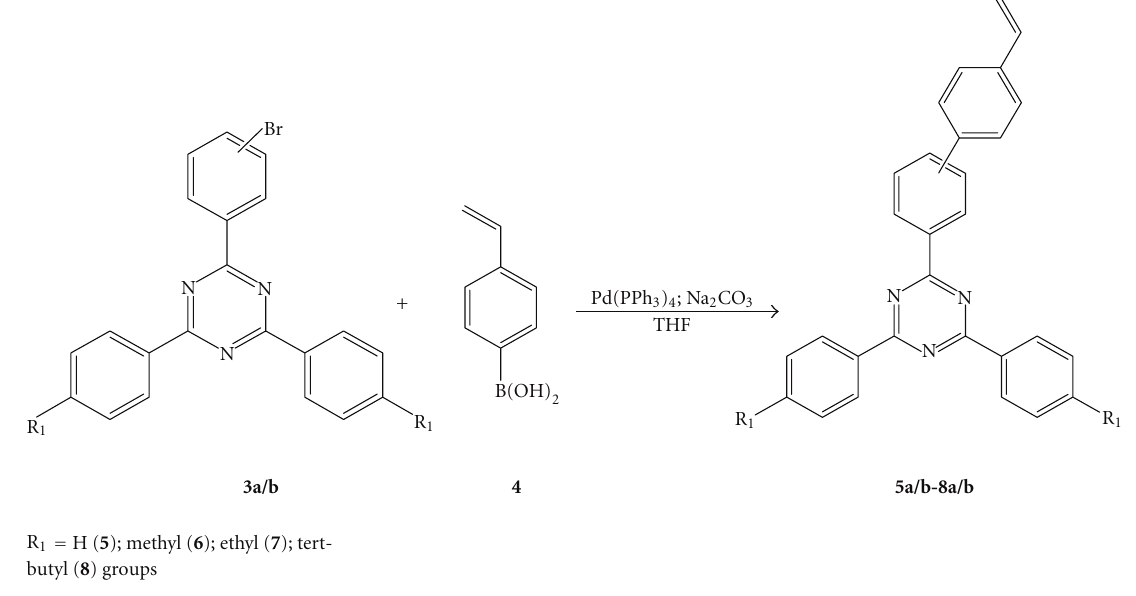
Figure 3: Introduction of styryl functionality by Suzuki coupling (a: meta; b: para). Table 1: Overview of the yields and inserted nitriles for the synthesized